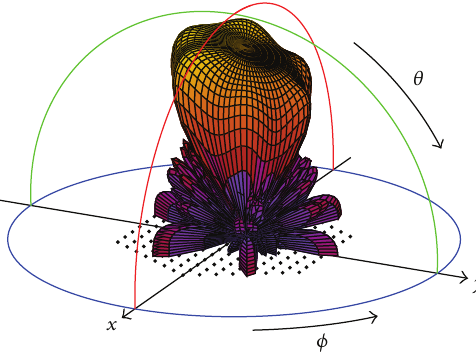
Figure12:Responseafterspreadingcollapseddistributions,without balancing the polynomial roots ( ∀𝑛 ∈ 1,...,4 | 𝑎 𝑛 > 0 ).